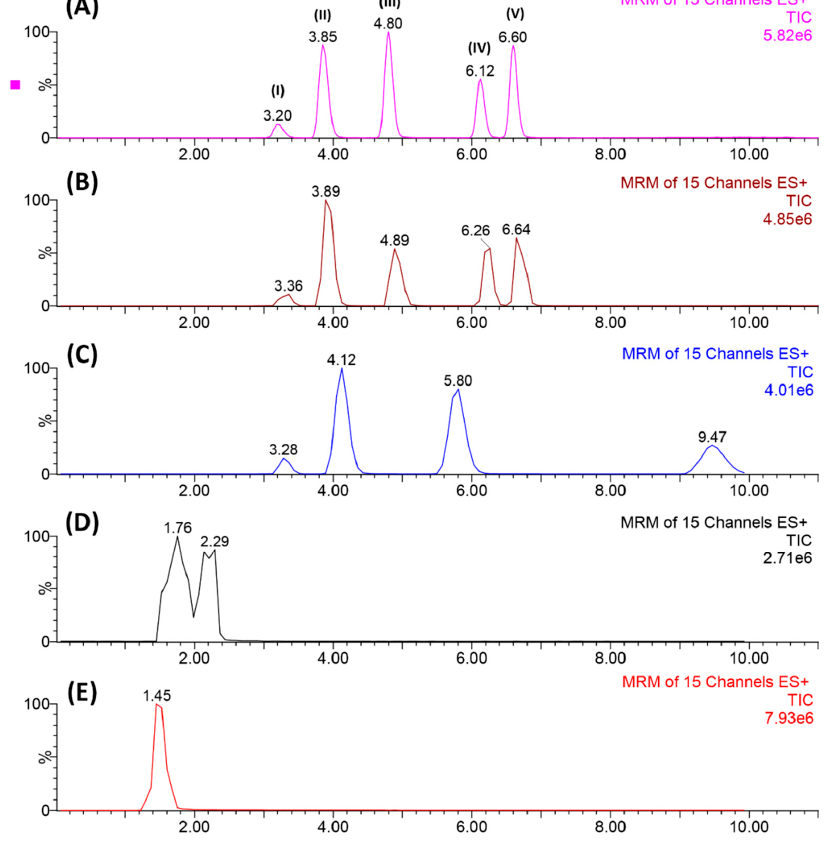
Figure 1. Representation of the chromatographic separation enhancement from E → A: ( A ) best condition applying elution gradient (H 2 O / ACN + 0.2% formic acid), ( B ) satisfactory separation but the dwell-time was not adjusted, ( C – E ) mobile phase without acidification and mobile flow rate not adjusted. Elution order: (I) carbamazepine, (II) citalopram, (III) desipramine, (IV) sertraline, and (V)